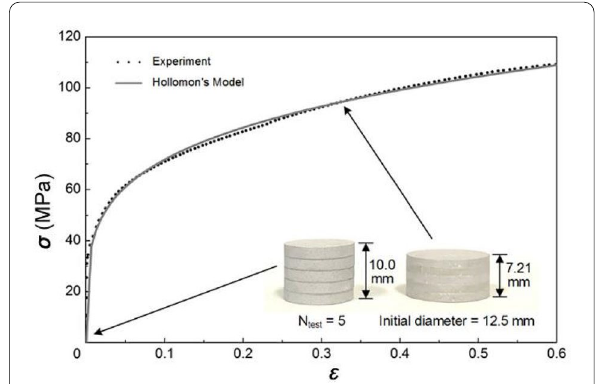
Figure 4 True stress–strain curve of aluminium 1060-O obtained from stack compression tests (insets show illustrations of specimens before and during